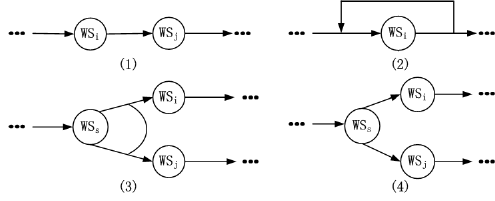
Fig. 1. Meta-control Logical Relation Between